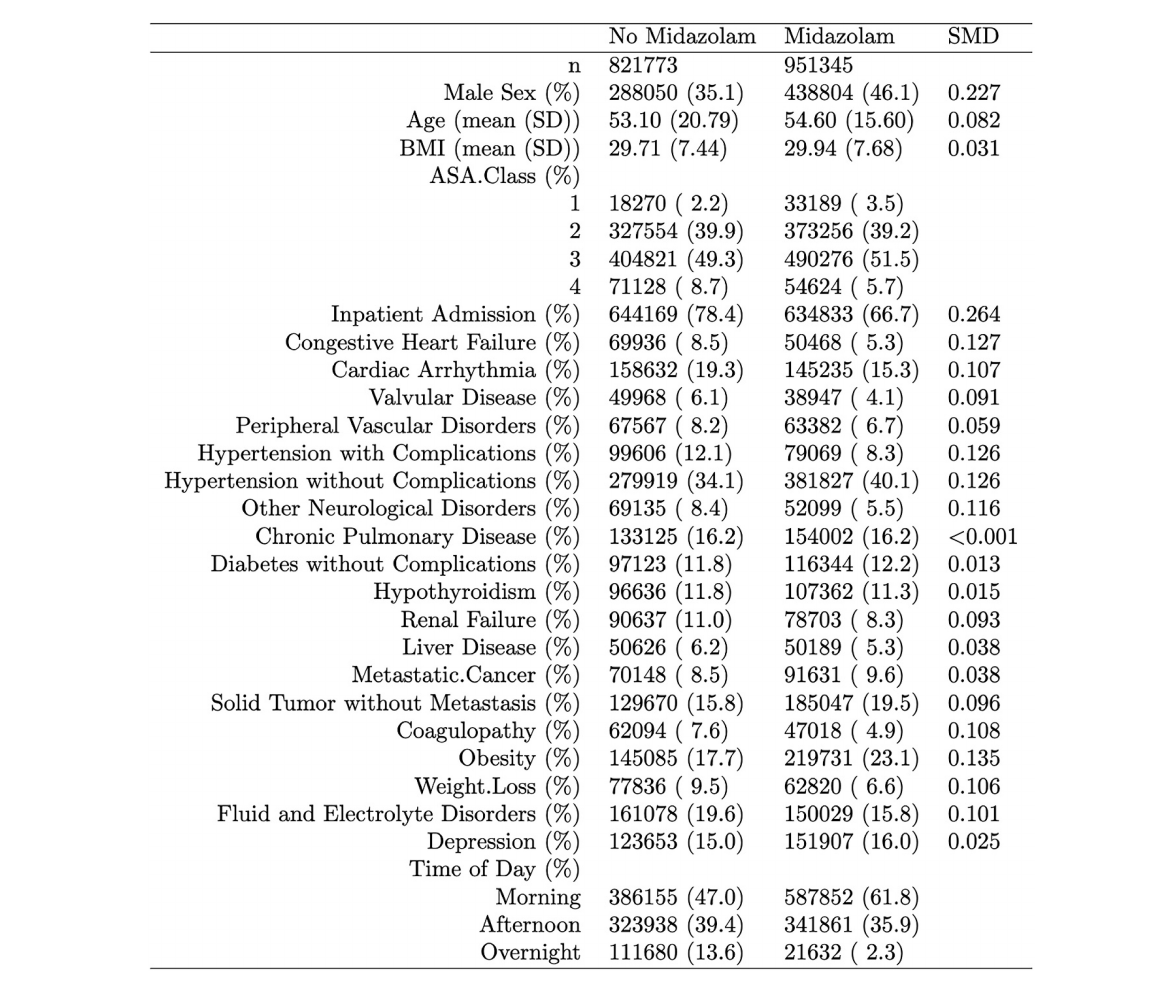
Figure 4 . Following propensity score correction, on average, no association between perioperative midazolam administration and the rate of MINS was observed (OR 0.98, CI